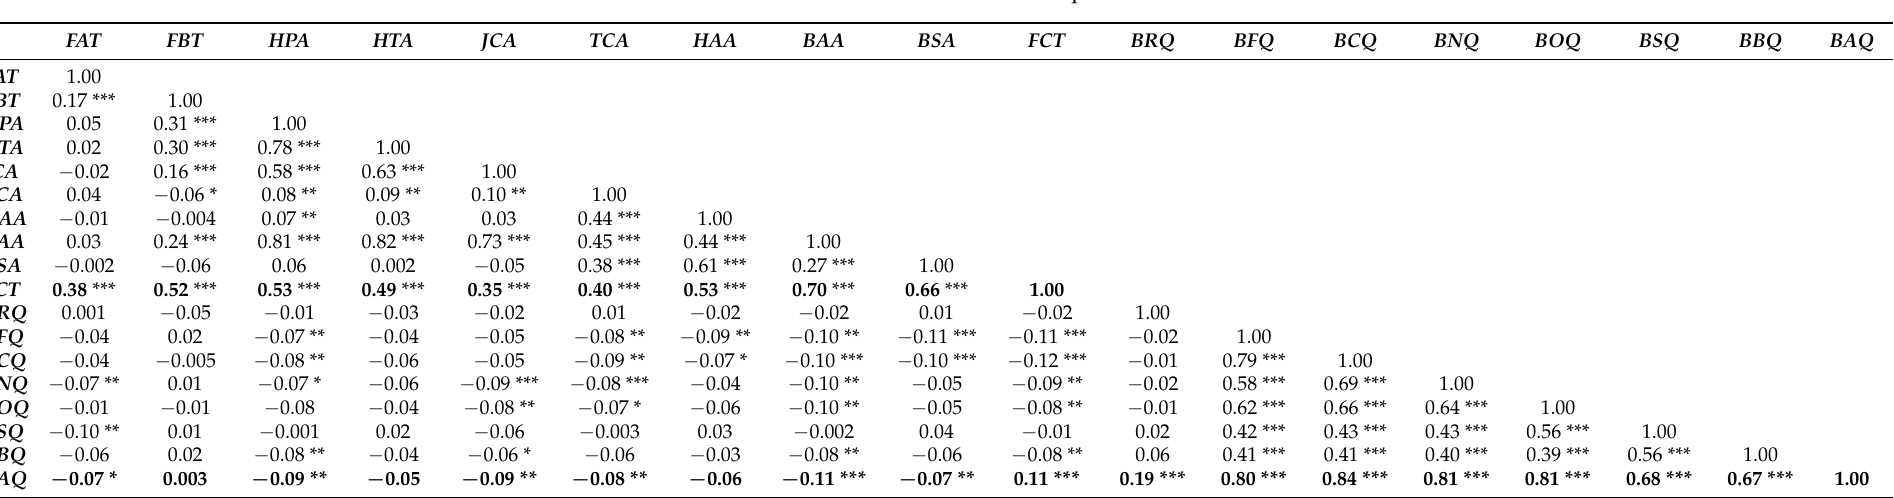
Table 8. The correlation matrix of hidden research variables for non-listed